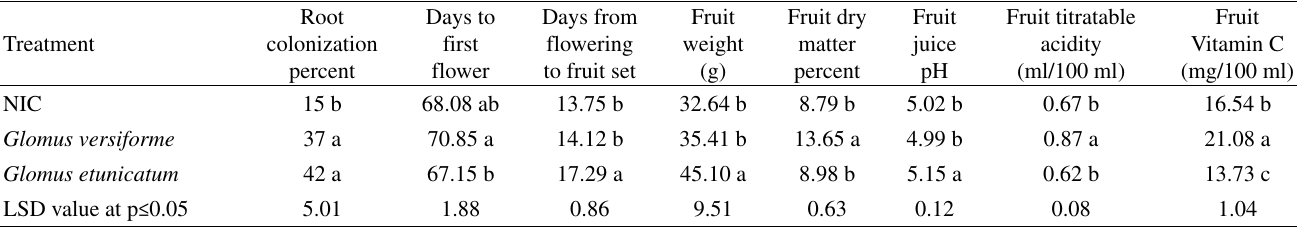
Table 4 - The main effects of arbuscular mycorrhizal fungi inoculation on some pepino plant characteristics Treatment